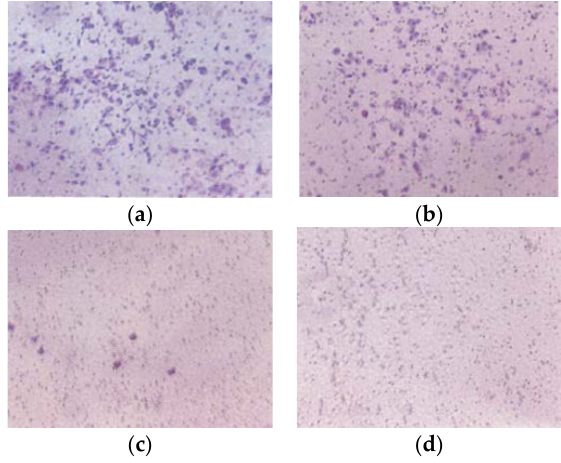
Figure 8. Effect of EPQ on Matrigel invasion of A-2780 cells: photomicrographs ( a ) Control, ( b ) EPQ 50 μg/mL, ( c ) EPQ 100 μg/mL, ( d ) EPQ 250 μg/mL.